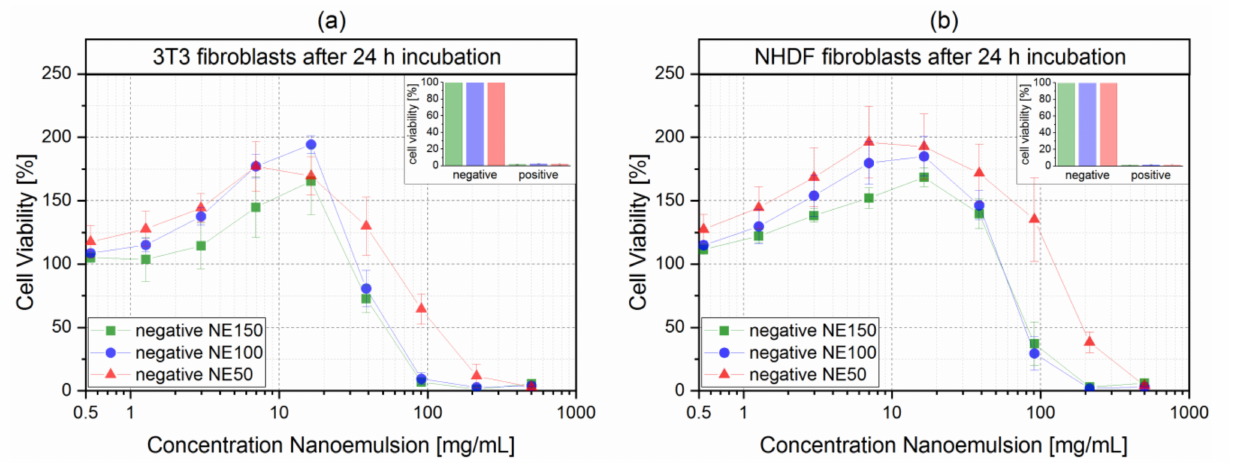
Figure 6. Dose-response curves of the cell viability over the total mass nanoemulsion (DiR loaded MCT, PG, MHS + aqueous phase) per lmL cell culture media on ( a ) 3T3 and ( b ) NHDF fibroblasts after 24 h incubation with the three negatively surface-charged nanoemulsions, determined by three individual incubated batches (eight replicates per run); the inlet graphs show the corresponding negative and positive controls with the untreated or TritonTM X-100 treated cells,